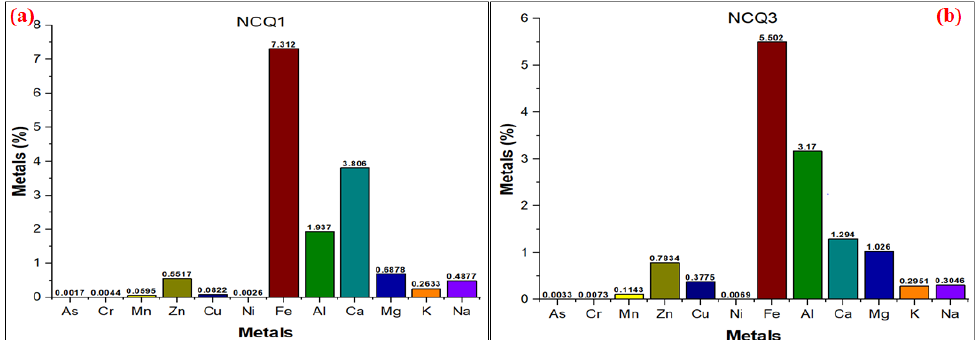
Figure 3. ( a ) ICP-MS of NCQ1 ( b ) and NCQ3 adsorbents.